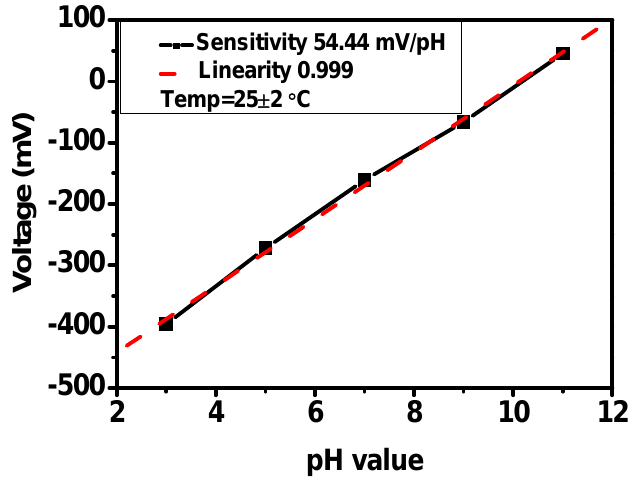
Figure 5. pH sensitivity of the anodized-ITO/ITO